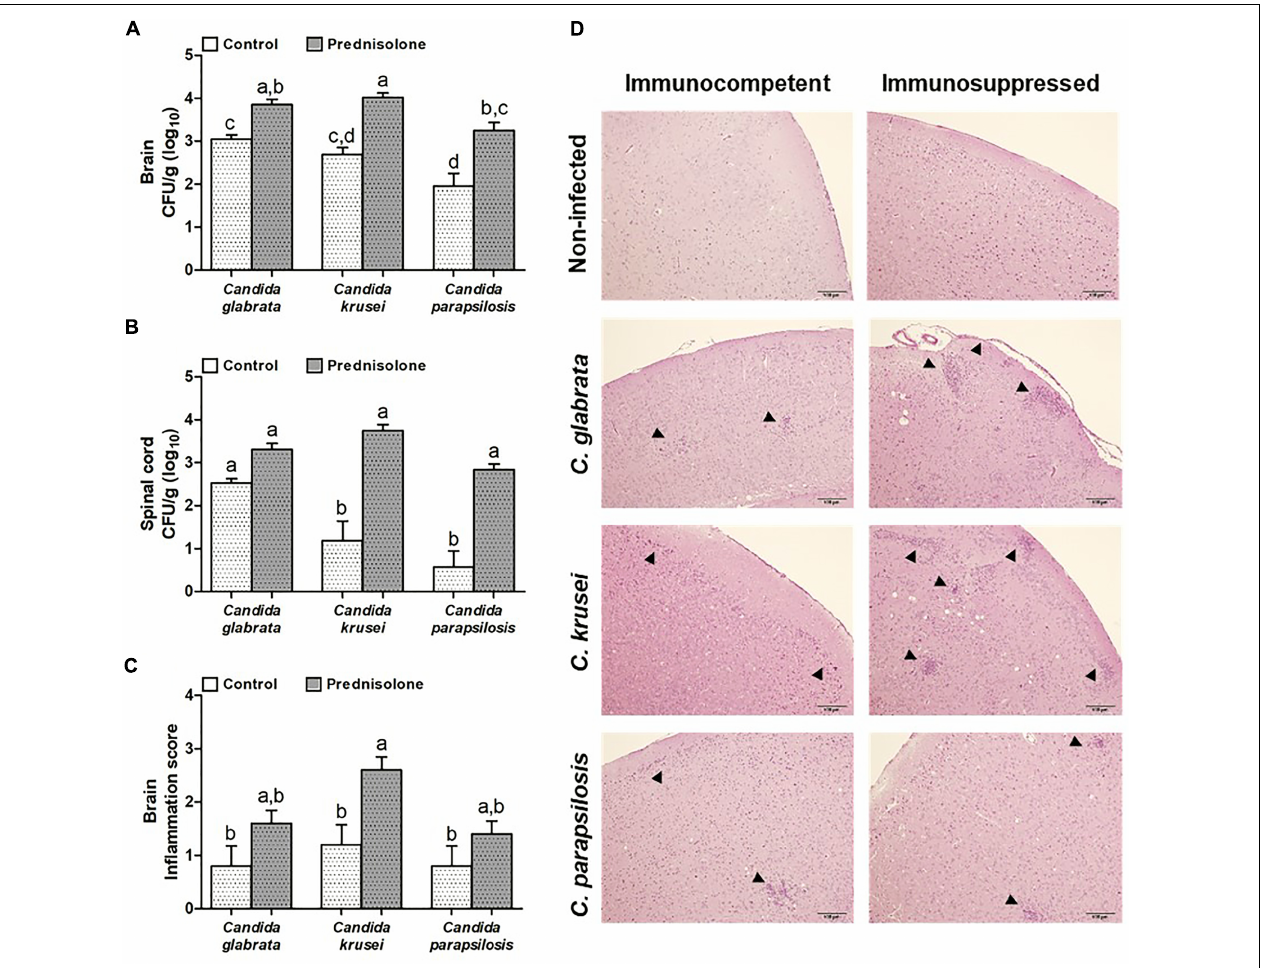
FIGURE 4 | Effect of prednisolone on fungal load and inflammation at the CNS. Fungal load of C. glabrata , C. krusei and C. parapsilosis in brain (A) and spinal cord (B) samples and inflammation score (C) in brain (D) of immunocompetent and immunosuppressed infected mice. The results are expressed as mean ± SEM (different letters indicate statistical difference among groups analyzed by One-way ANOVA with post hoc Tukey test; p < 0.05; n = 8 for CFU and n = 5 for inflammation score). Arrowheads indicate diffuse inflammatory infiltration and focus of inflammatory